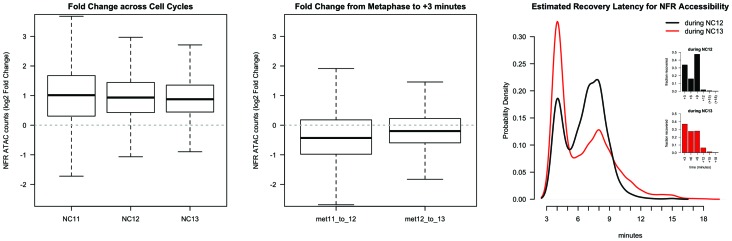
Changes in accessibility at nucleosome-free regions over the cell cycle.To calculate changes in chromatin accessibility at NFRs over the cell cycle, the maximum extent of each NFR was calculated from the predicted extreme positions of −1 and +1 nucleosomes as determined by NucleoATAC. For each timepoint, the maximum ATAC-seq count value corresponding to open and accessible chromatin was calculated for each NFR (n = 2470) and plotted. Chromatin accessibility at NFRs doubles on average over the course of each cell cycle (Left Panel). The boxplots show the calculated log2 fold change between the first and last timepoint in each indicated cell cycle for each NFR. A greater negative log2 fold change in accessbility is observed between metaphase 11 and early interphase 12 than between metaphase 12 and interphase 13 (Middle Panel). The dotted grey line indicates no difference in fold change between compared timepoints. To estimate the latency in recovery of accessibility to prior levels of chromatin accessibility, data for each NFR was subjected to spline interpolation and the timepoint when accessibility in the following cell cycle is equal to or greater than accessibility for the preceding metaphase was calculated. The right panel shows the kernel density estimate for the distribution of latency times for recovery during NC12 and NC13 (black and red traces, respectively). The distribution of latency estimates is biphasic for both cell cycles, with NC12 showing nearly equivalent distribution between early (3 min) and late (9 min) recovering regions. A larger proportion of NFRs recover by 3 min during NC13. Median values for raw, non-interpolated data (inset) are +9 min for NC12, and +6 min for NC13.